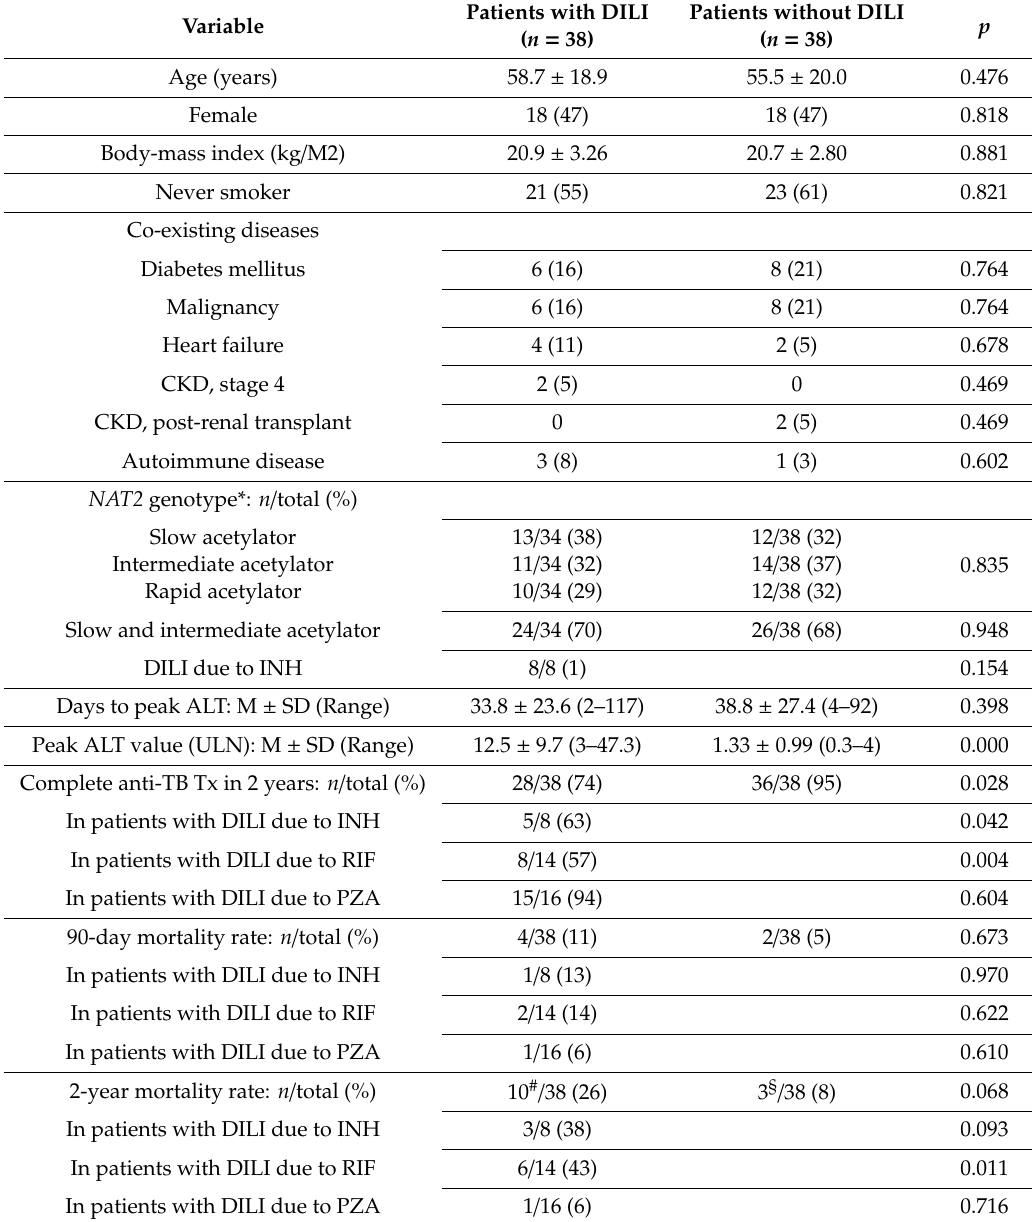
Table 1. Clinical characteristics and N- acetyltransferase 2 ( NAT2 ) genotype of tuberculosis (TB) patients with and without drug-induced liver injury (DILI) due to anti-TB